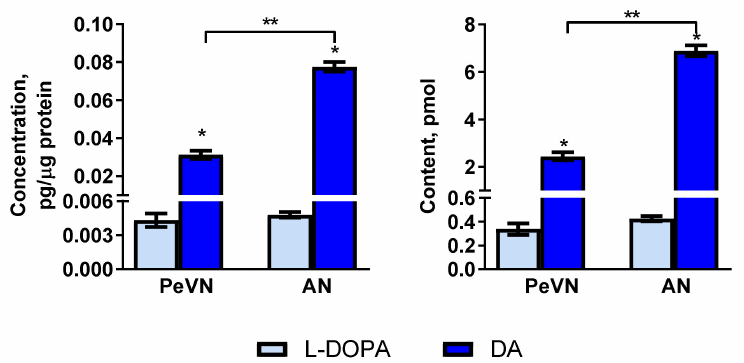
Figure 1. Content and concentration of L-DOPA and dopamine (DA) in the periventricular nucleus (PeVN) and arcuate nucleus (AN) of rats. * p < 0.05, significant differences between L-DOPA and dopamine levels; ** p < 0.05, significant differences between selected parameters.